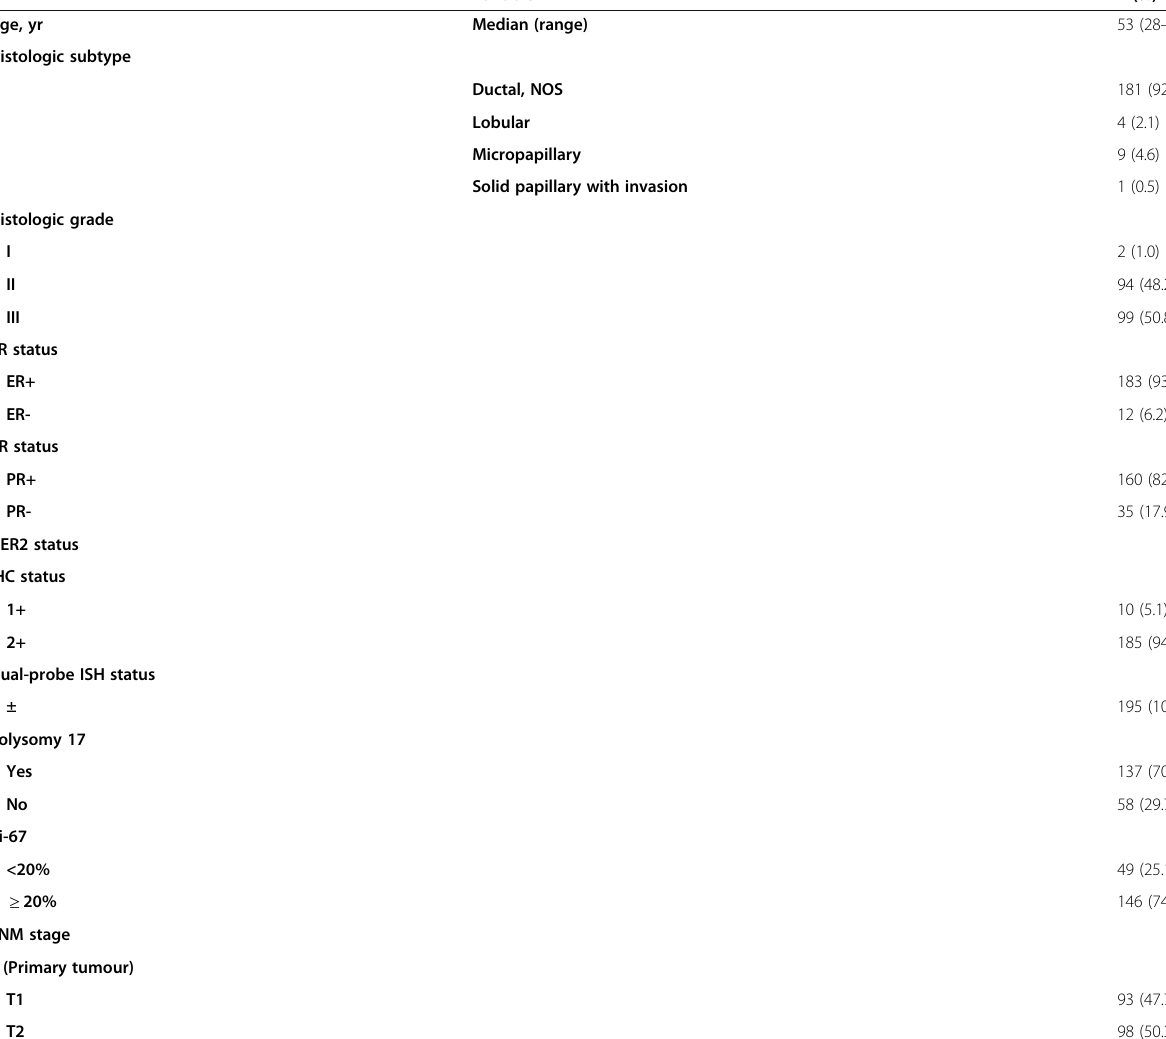
Table 1 Characteristics of study